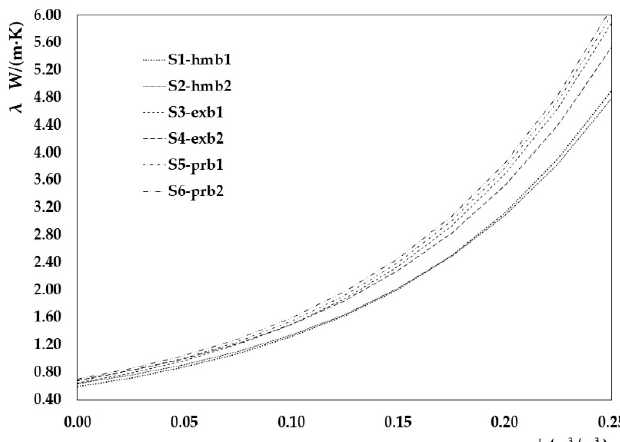
Figure 6. Results of the analytical calculation of the conductivity of dry samples with different moisture contents according to the different densities established in the EN 1745 standard [26].